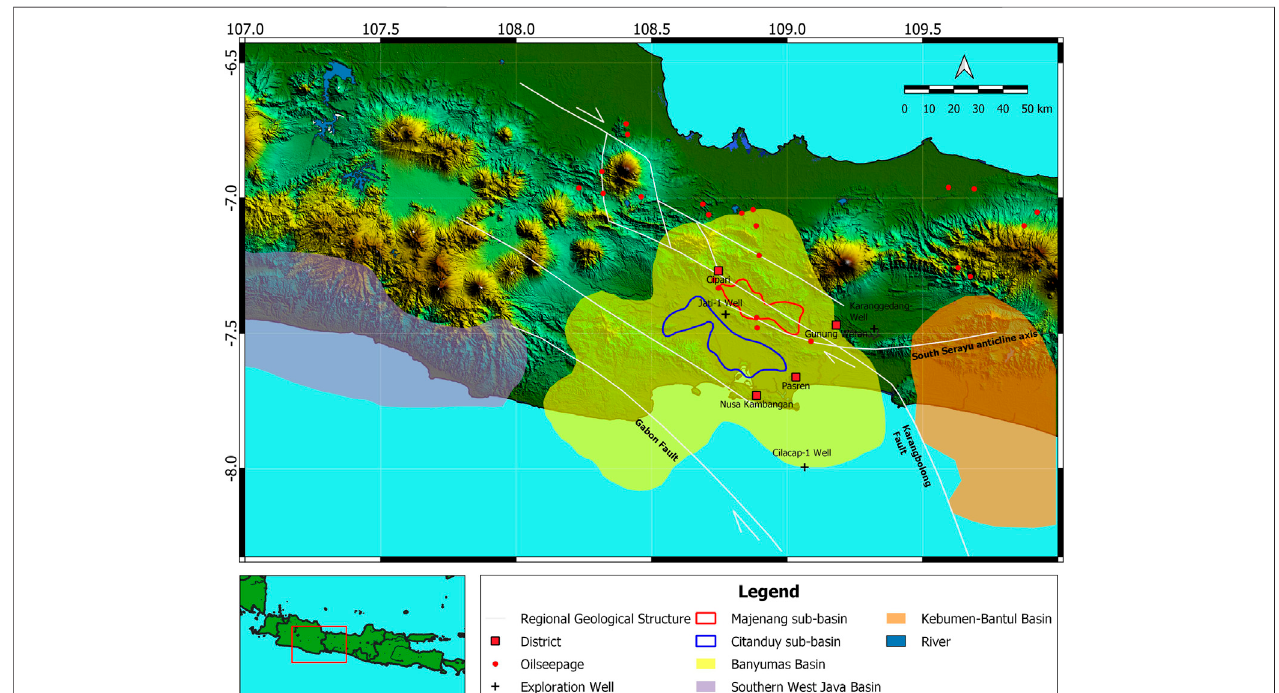
FIGURE 1 | Map of the regional geological structure and the Banyumas Basin boundary (modi fi ed from the Geology Agency., 2009; Muchsin et al., 2002; Armandita et al., 2009; Satyana, 2015; Lunt et al., 2009; Hidayat et al., 2020).